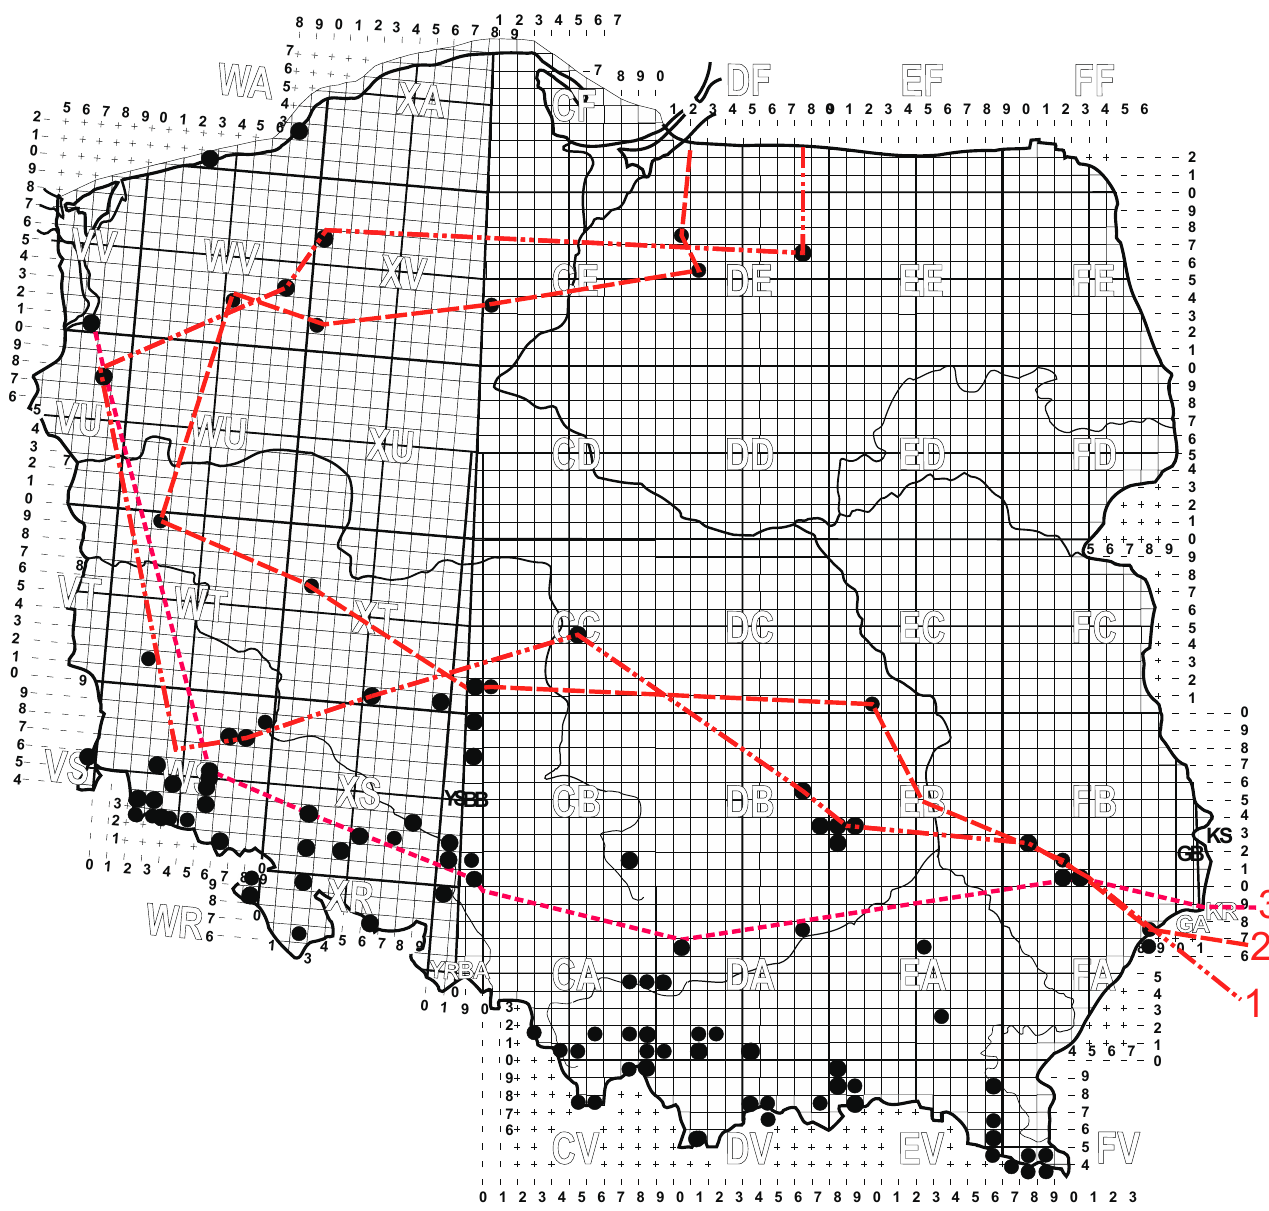
Figure 5. Geographical distribution of species which have their north-eastern range of occurrence in Poland: 1– Polyaspinus cylindricus , 2— Olodiscus misella, 3— Cilliba erlangensis.